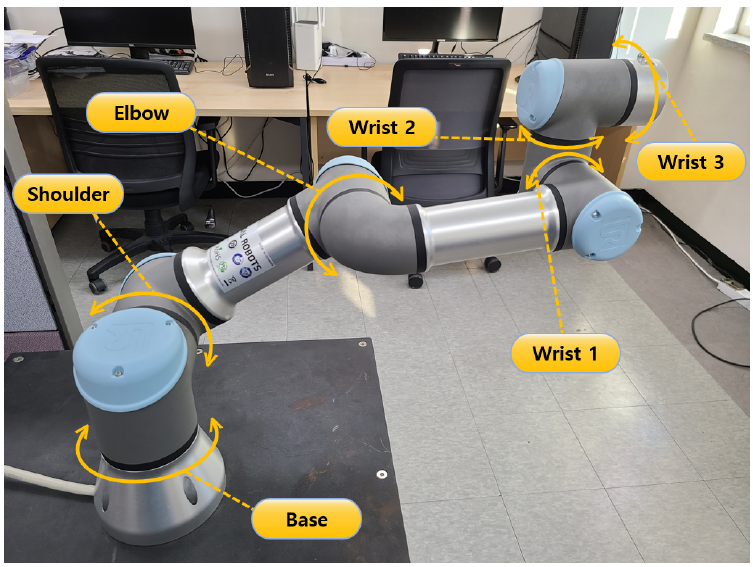
Figure 2. Industrial robot UR3 used to test the proposed system. The manipulator processes six degrees of